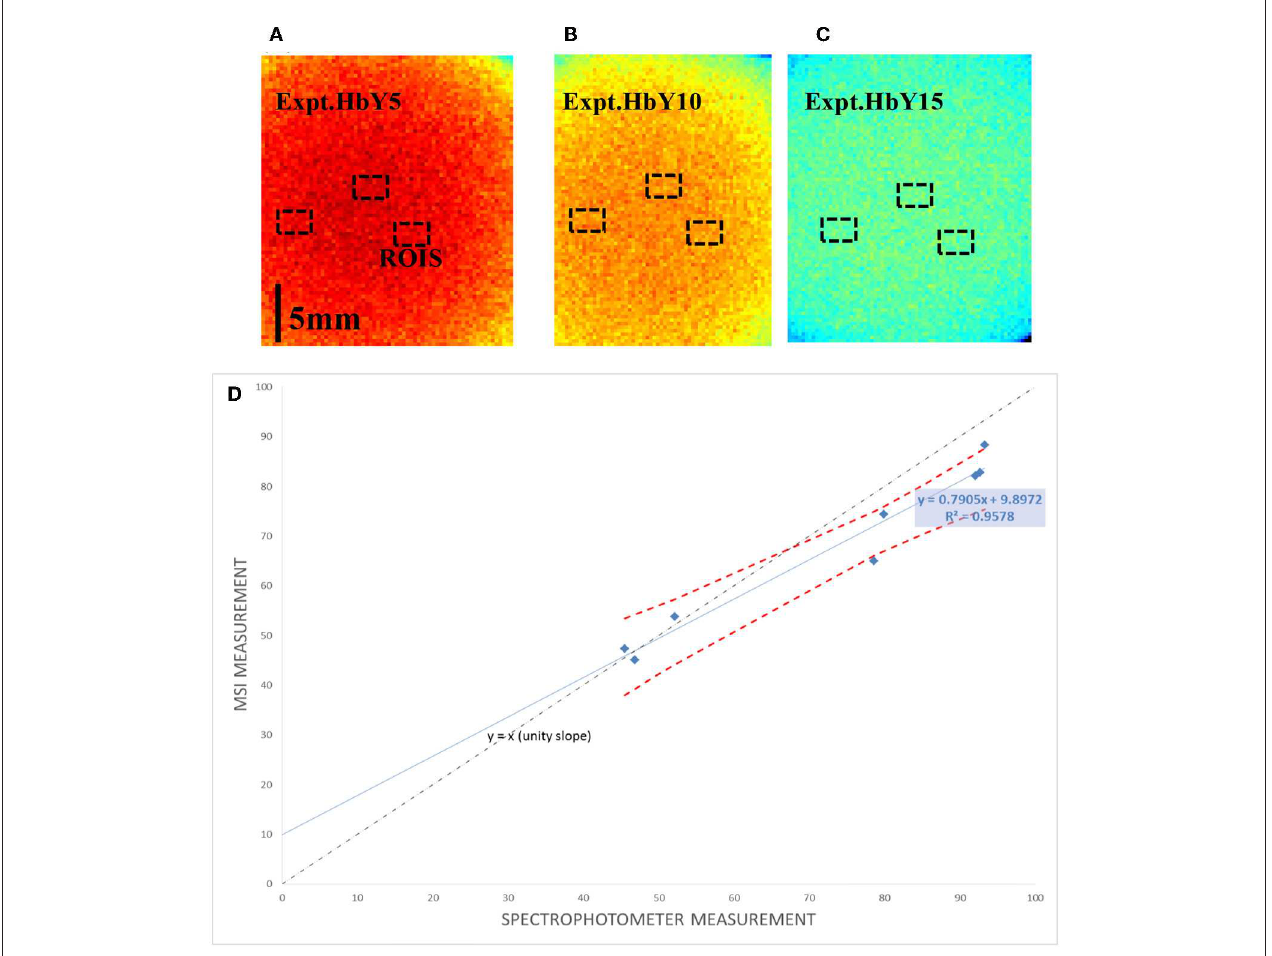
FIGURE 5 | Measurement with the multi-spectral imaging system (MSI): (A–C) example multi-spectral reflectance images of three selected phantoms with ROIs, (D) the corresponding StO2 measured with MSI measurement vs. transmission method. Red dotted line in (D) represents 95% confidence interval.